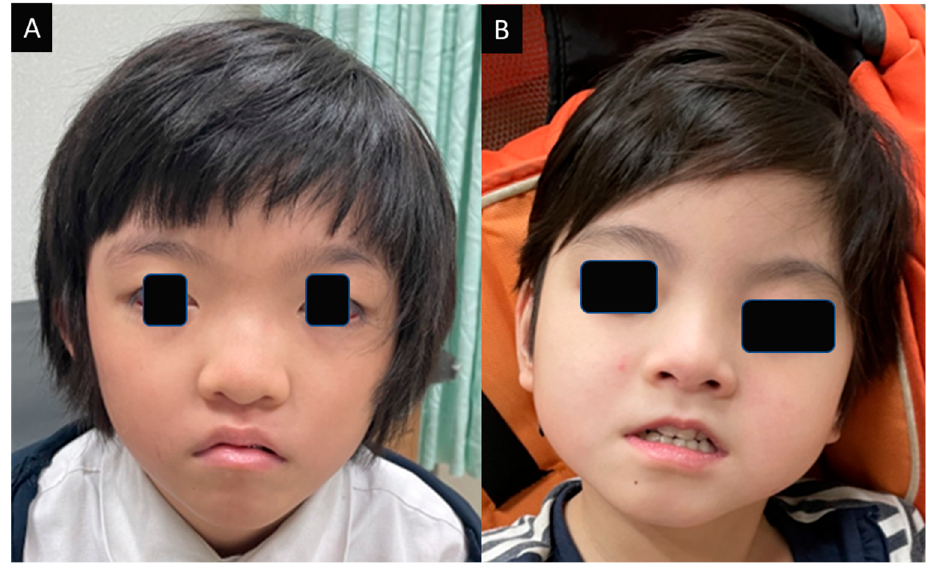
Figure 2 . Facial features. Both Case 2 ( A ) and Case 3 ( B ) had facial dysmorphism, including syn- ophrys (meeting of the medial light, sparse eyebrows in the midline), hypertelorism, downward-slanting palpebral fissures, a thin upper lip vermilion, and down-turned corners of the mouth (photos were captured by mobile iPhone 12).